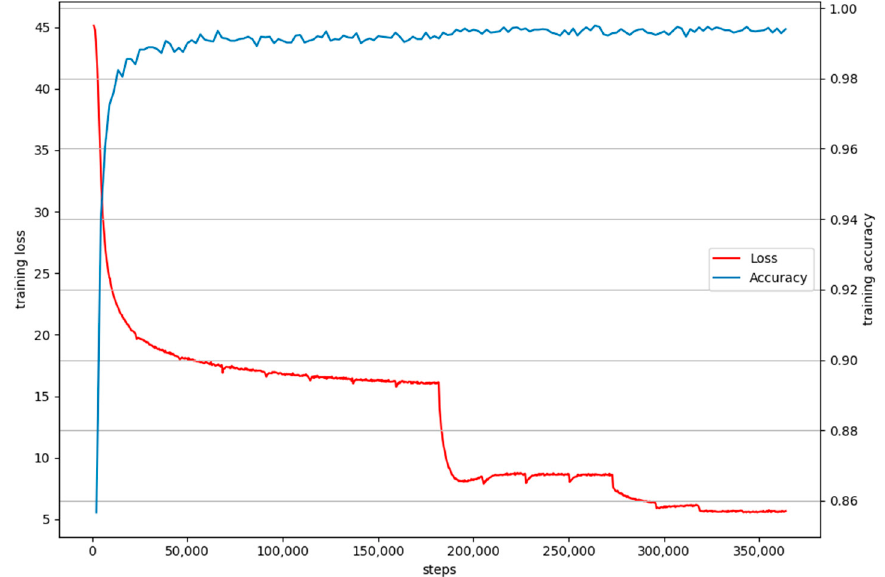
Figure 6. The curves of training loss and accuracy on LFW of the baseline.